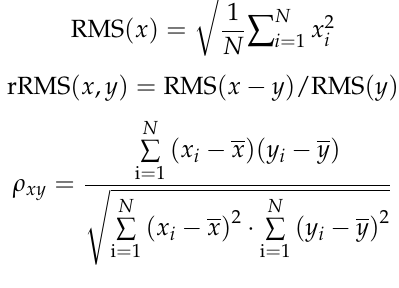
Table 1. The SLR and HLSST data are combined at the normal equation level using